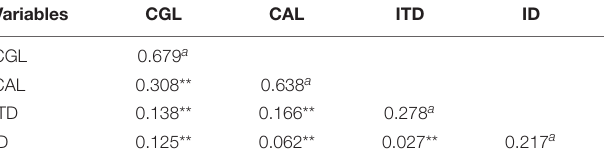
TABLE 4 | Discriminant validity. Variables